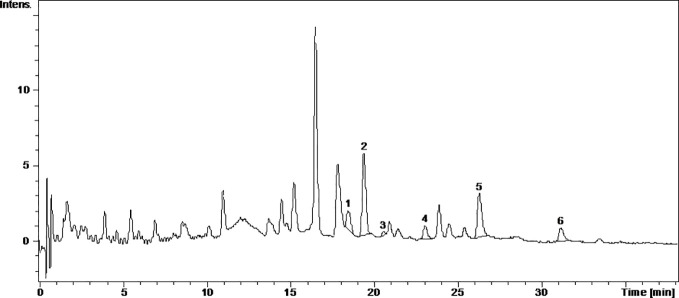
The UV chromatogram of fresh Fetească neagră 2015 grape pomace extract. 1, Hyperoside; 2, Isoquercitrin; 3, Miricetol; 4, Quercitrin; 5, Quercetin; 6, Kaempferol.